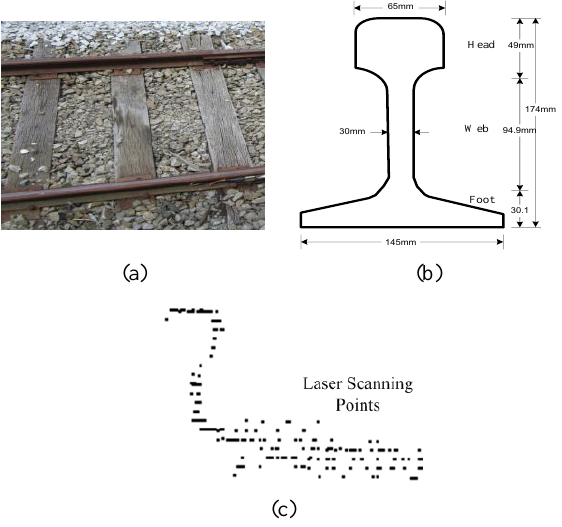
Figure 3. Railway formation: (a) track region image, (b) KS-60 railway track standard (KRRI, Korean Rail Research Institute), and (c) laser scanning points representing the